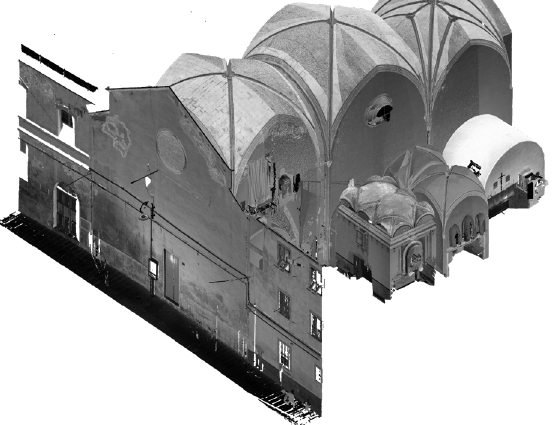
Figure 12 . Point cloud digital model of the Church of Santa Lucia.